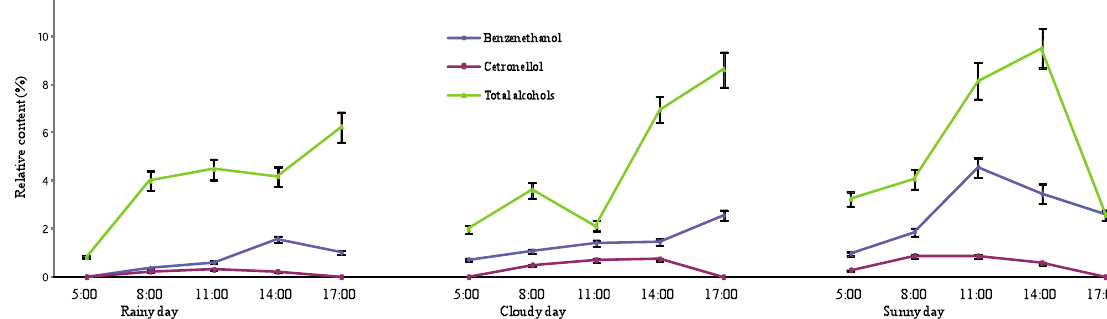
Fig. 4: Diurnal dynamics of alcohols in volatile emissions from flowers of four seasons rose